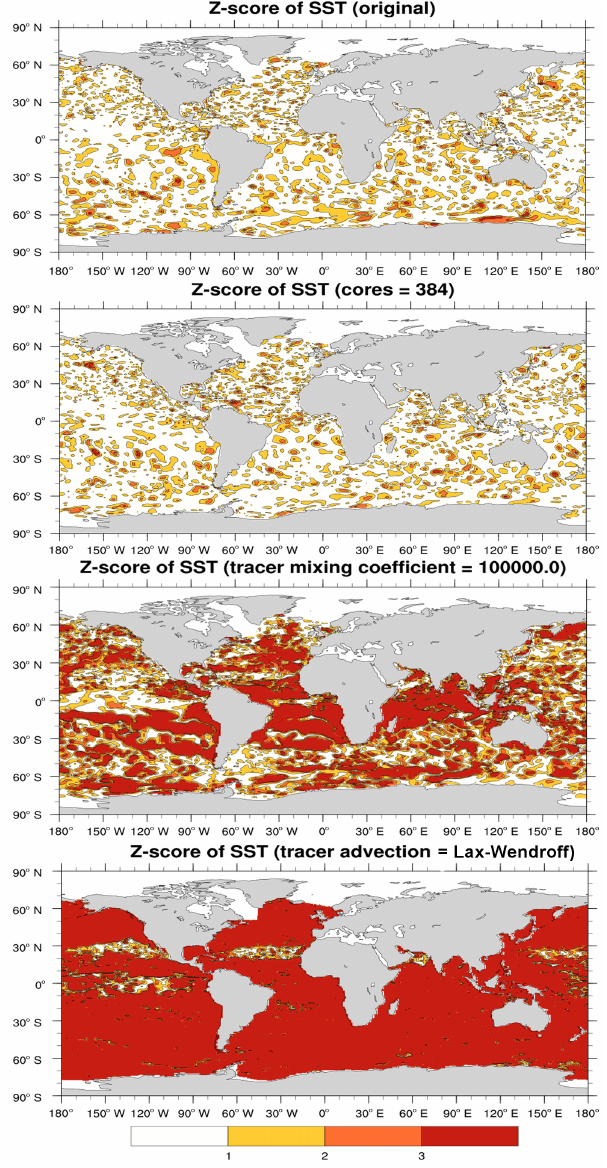
Figure 11. Z -score of sea surface temperature (SST) at month 12 for the original (default) case, a 384 processor core case, a case with a 10 times larger tracer mixing coefficient for convective instability (100000.0), and a case with an alternate tracer advection scheme (Lax–Wendroff scheme with 1-D flux limiters).